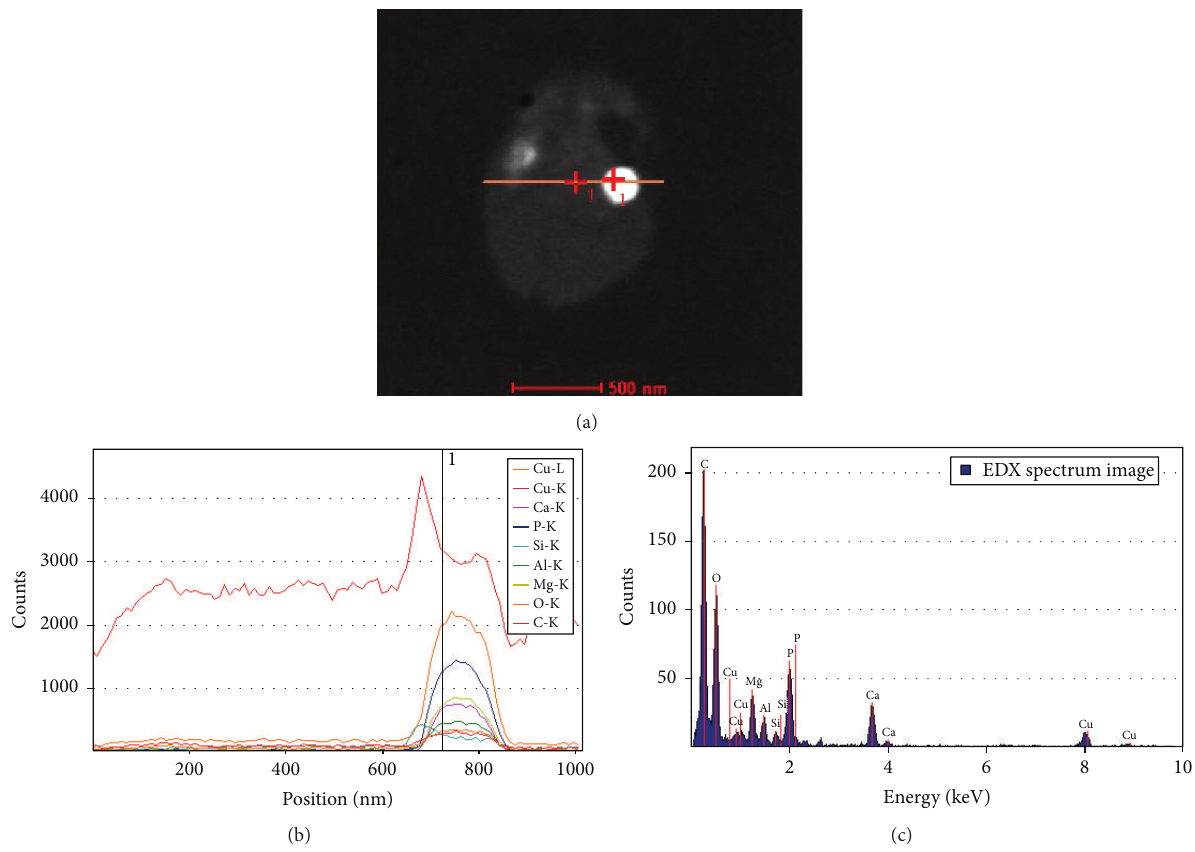
Figure 4: Elemental composition through a granule cross section by EDX analysis. (a) STEM image of the analyzed cell; the path of the probe is shown as an orange line. (b) The EDX line spectra across the cell shown in (a). Each element is plotted in a different color. (c) The individual EDX point spectrum from the location specified in (a) by a cross with the number 1 and in (b) by a vertical